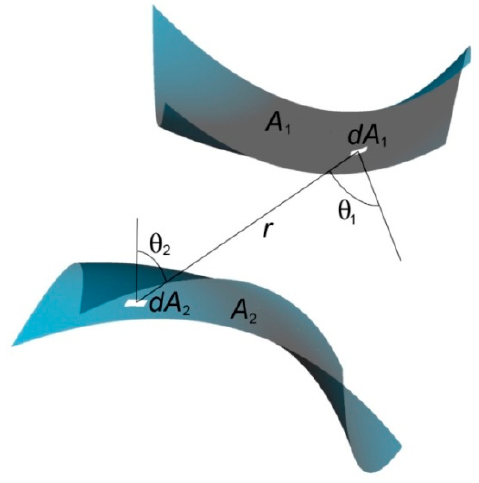
Figure 1. General three-dimensional arrangement of surface source elements through which the radiation form factor is defined.